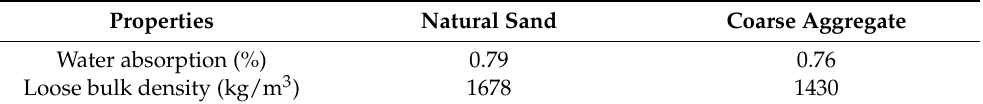
Table 4. Mixture proportions of concrete (kg/m 3 ). Table 2. Properties of aggregates.